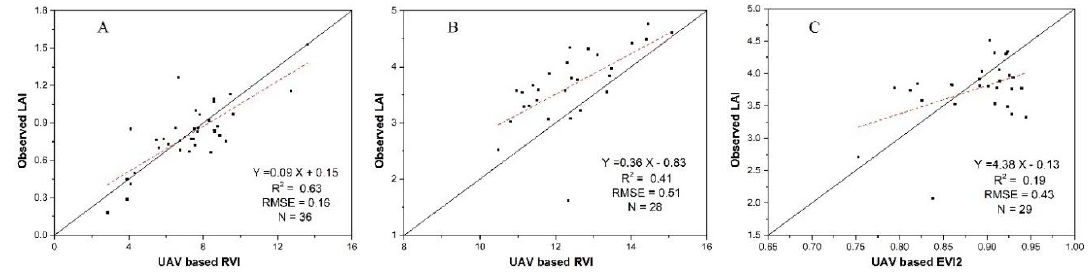
Figure 5. Established empirical vegetation index models ( A ) 30 June, ( B ) 29 July, ( C ) 25 August.